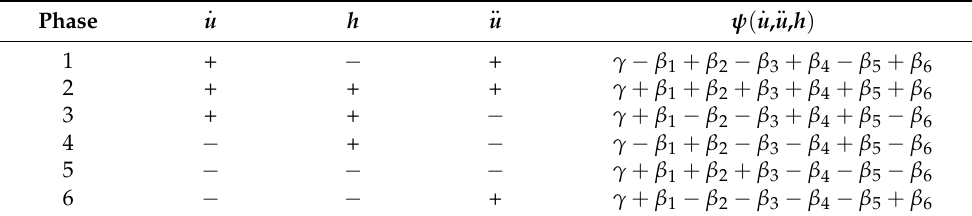
Figure 5. Values of modified shape control function. Table 1. Values of the shape control function for MBW